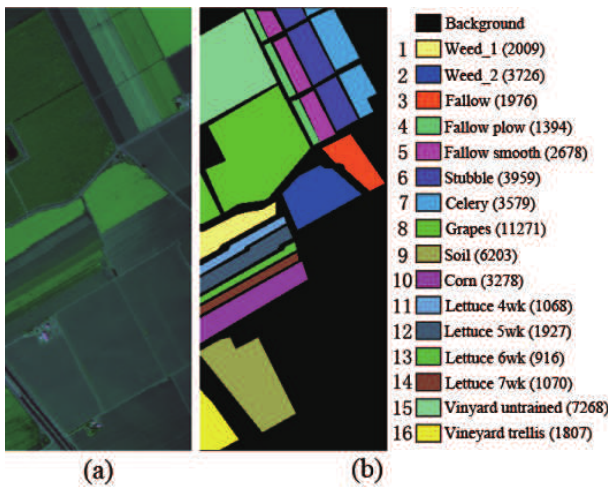
Figure 4. Salinas hyperspectral image. ( a ) HSI in false color; ( b ) Ground truth.